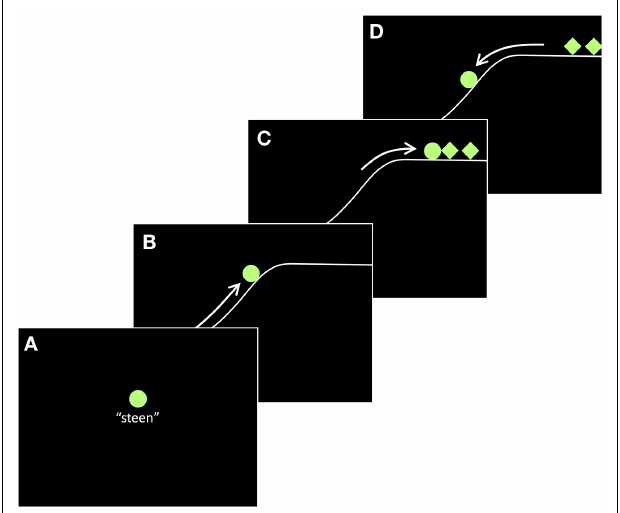
FIGURE 1 | Example of an incongruent stimulus item in Experiment 1, with the target figure moving in an animate manner, but having the inanimate lexical label steen “stone.” The four frames (A–D) are stills taken from a continuous animation. Letters indicate order; arrows indicate movement. Both were not shown in the